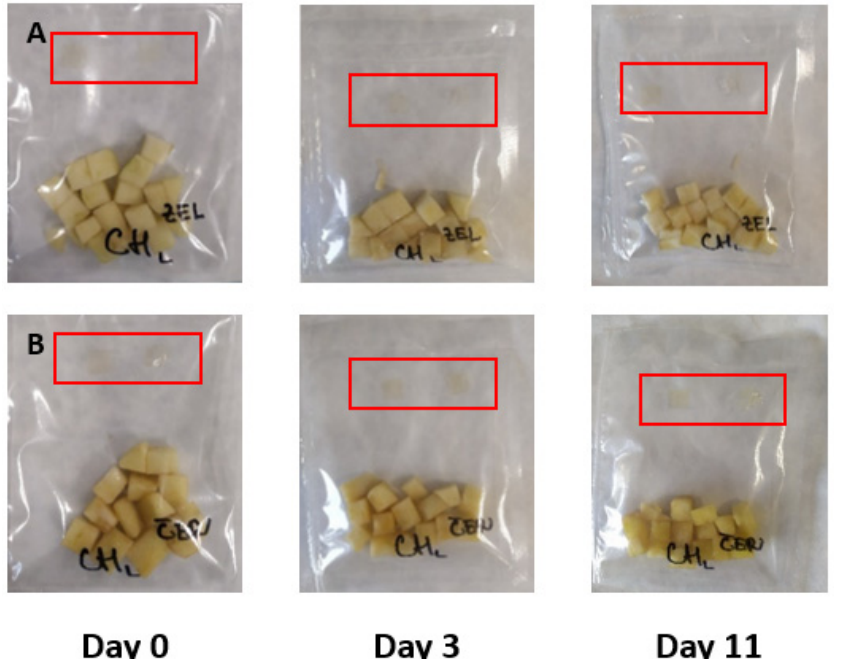
Figure 6. Green ( A ) and red ( B ) apples packaged with pieces of film made without the addition of extracts.